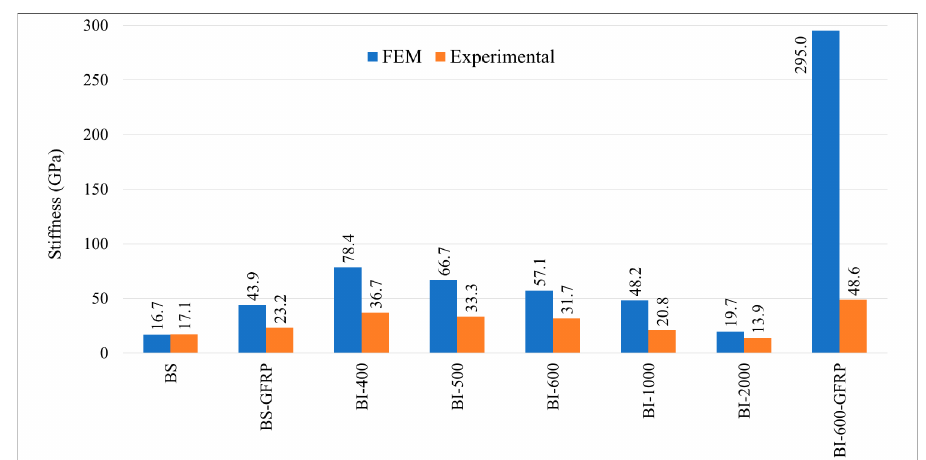
Figure 24. Bilinear graph for C-NS beam.